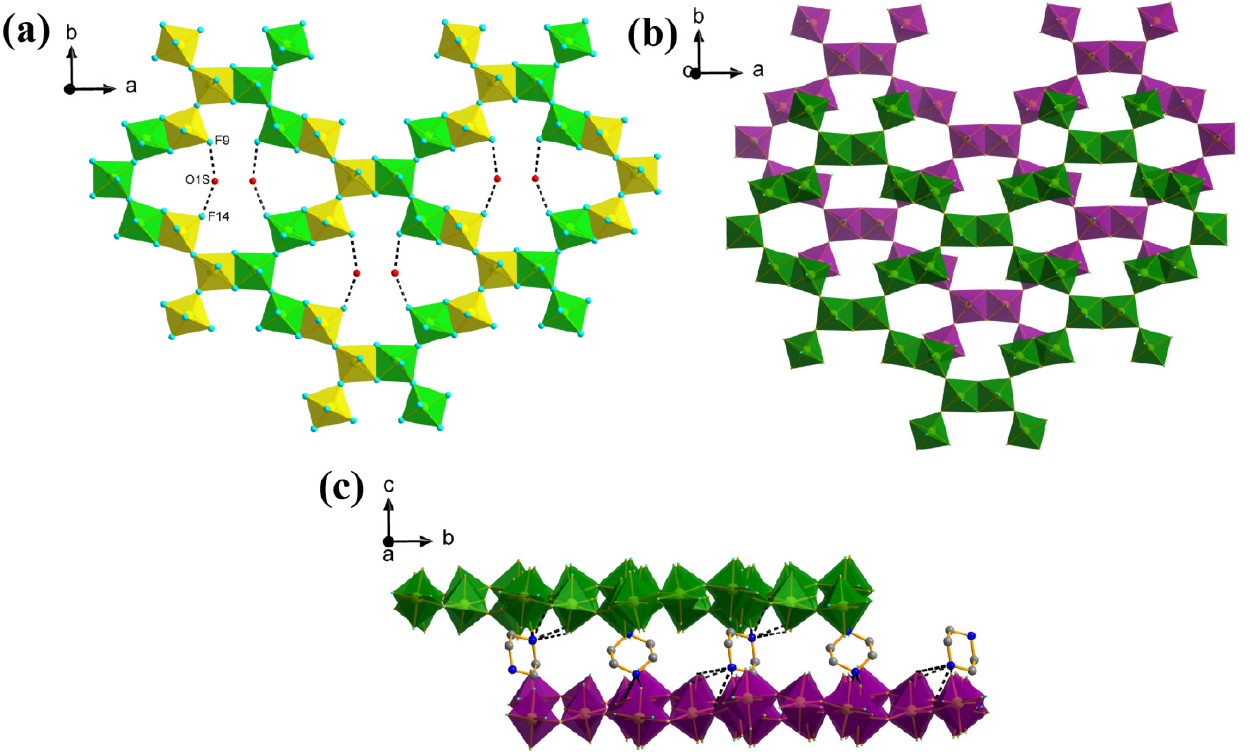
Figure 6. ( a ) The 2D layers with channel water molecules of 2 . The octahedra with different colours show how the “V” shaped Fe-F building units are connected. (Hydrogen bonds are depicted by dotted lines); ( b ) Plan view of the layer stacking with different layers are shown in different colours. (H 2 pipz and water molecules are eliminated for clarity); ( c ) The stacking of the layers with H 2 pipz along the c -axis of 2 (Selected hydrogen atoms are eliminated for clarity but hydrogen bonds are depicted by dotted